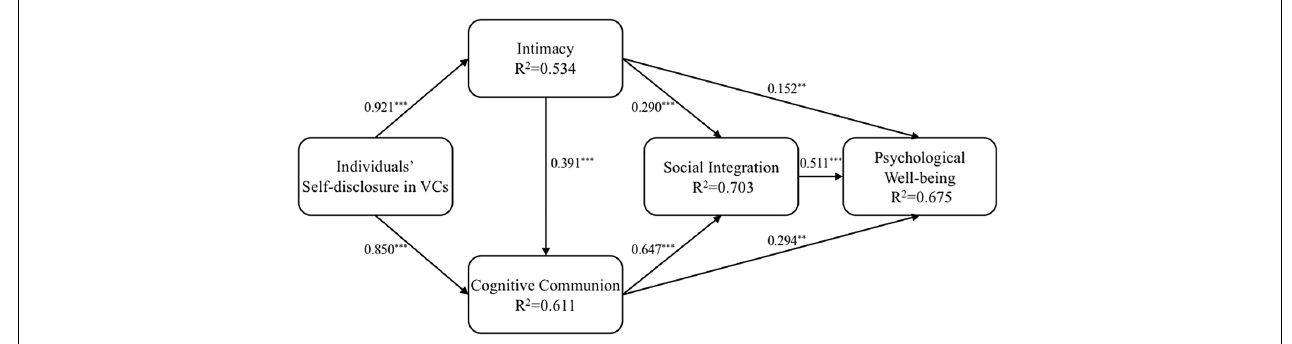
FIGURE 2 | Model testing results. ** p < 0.05; *** p <